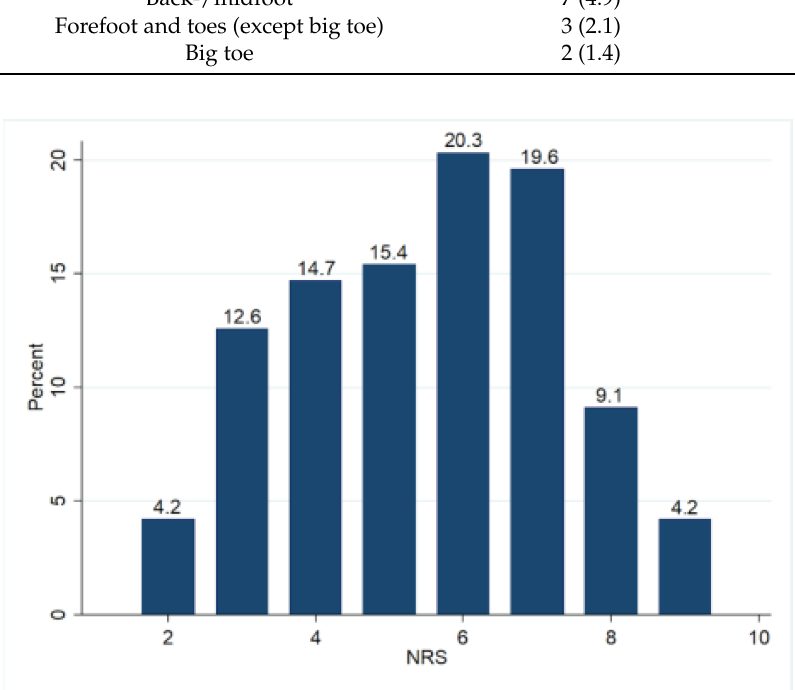
Figure 1. Frequency of pain intensities on the Numeric Rating Scale (0 = no pain; 10 = worst conceivable pain) in the most affected body regions of dance teachers (n =